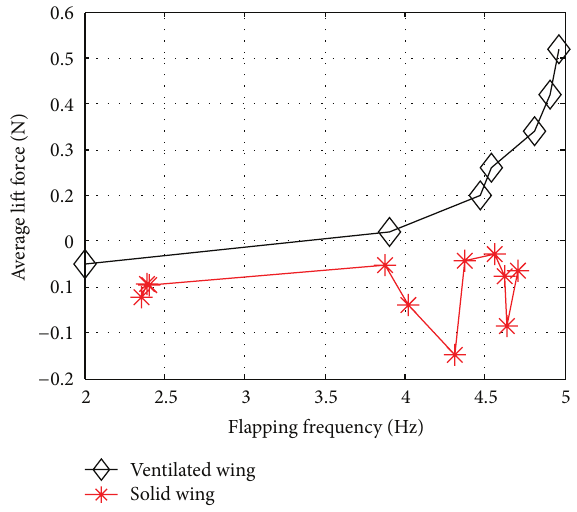
Figure 6: The average lift force characteristic for the ventilated wing versus solid